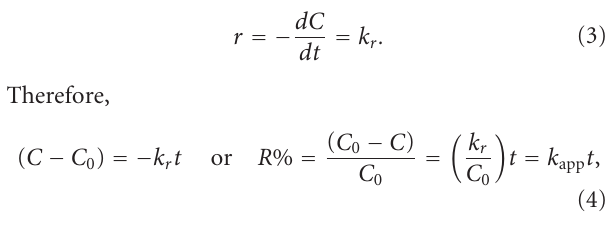
Figure 10: TOC removal percentage of E. coli versus UV light ir- radiation by using TiO 2 and Ag-TiO 2 as photocatalysts.